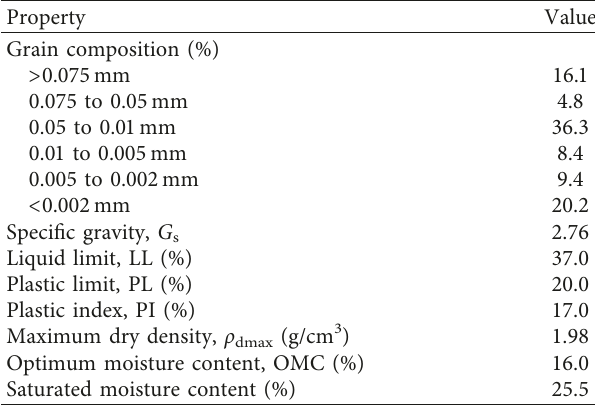
Table 1: Basic material properties of the tested